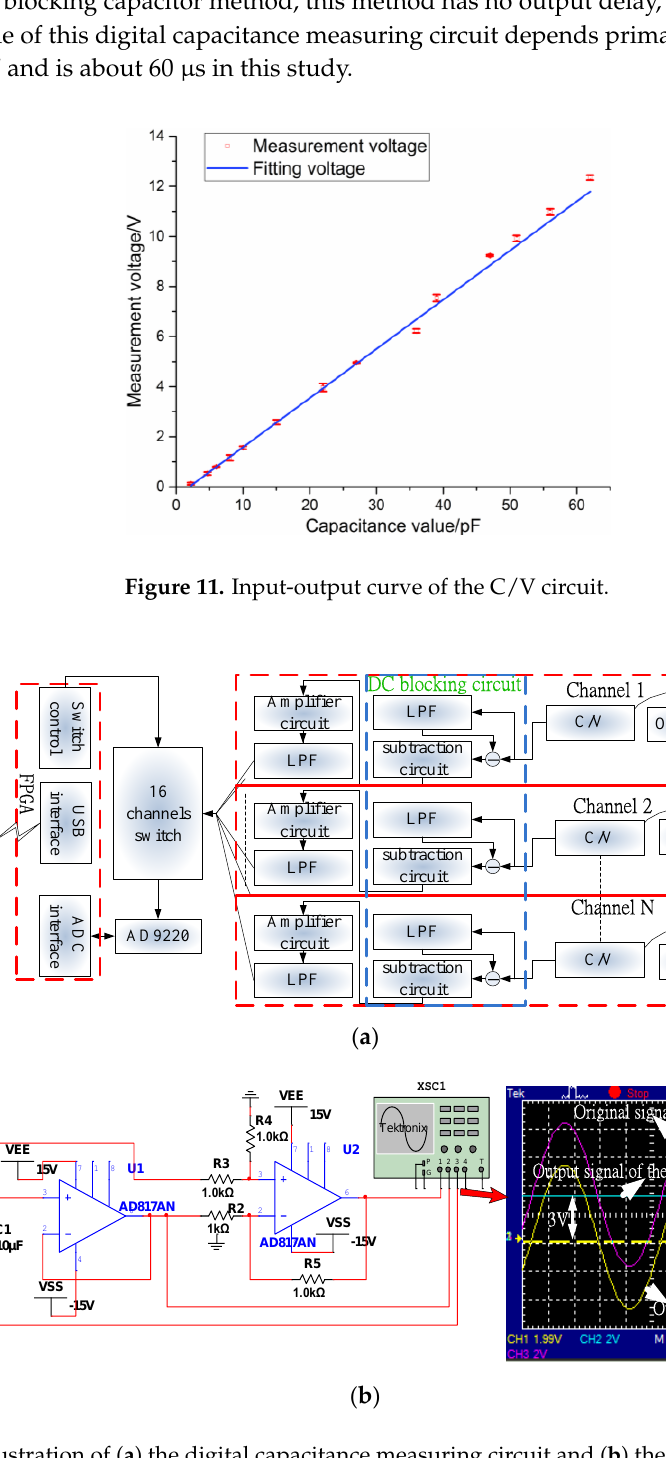
Figure 12. Illustration of ( a ) the digital capacitance measuring circuit and ( b ) the DC blocking